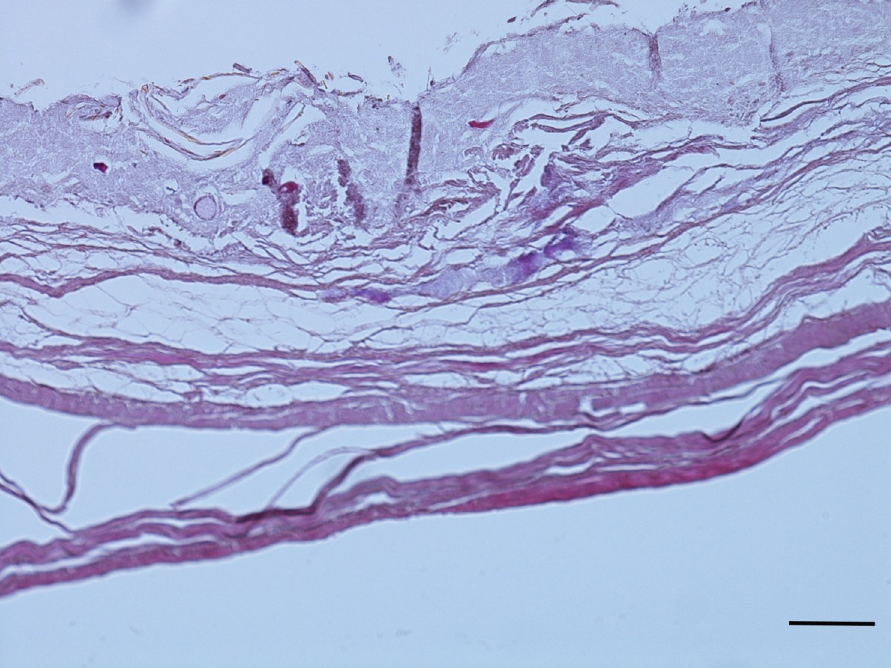
Fig 16. Histological preparation of the cystic wall showing a pseudocapsule and amorphous inner material. (Elastica-van Gieson); bar = 200 μ m.